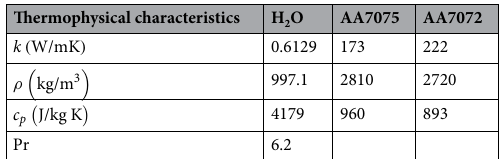
Table 1. Experimental physical data of water and hybrid